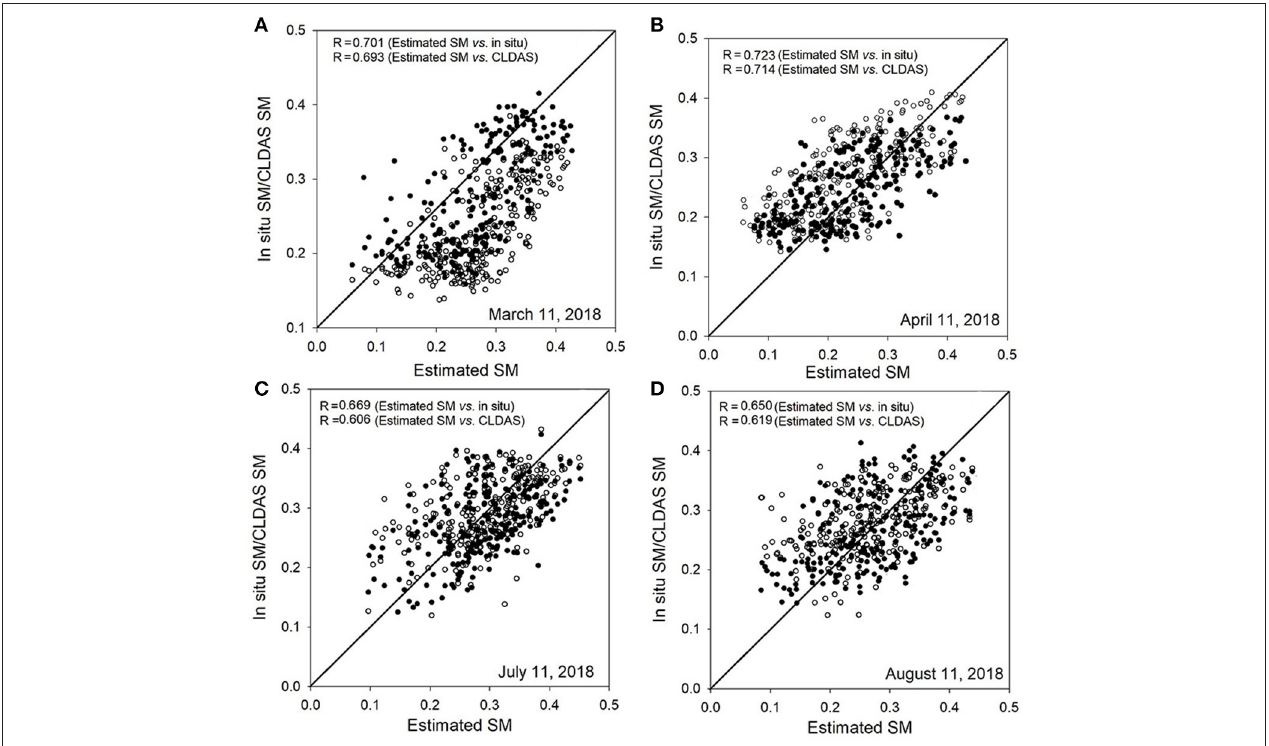
FIGURE 11 | Validations of estimated SM against CLDAS and in situ SM at four days in 2018 over southeast Mainland China. The solid point represents estimated sm vs. in situ SM, and the hollow point represents estimated sm vs. CLDAS SM. (A) March 11, 2018, (B) April 11, 2018, (C) July 11, 2018, and (D) August 11, 2018.